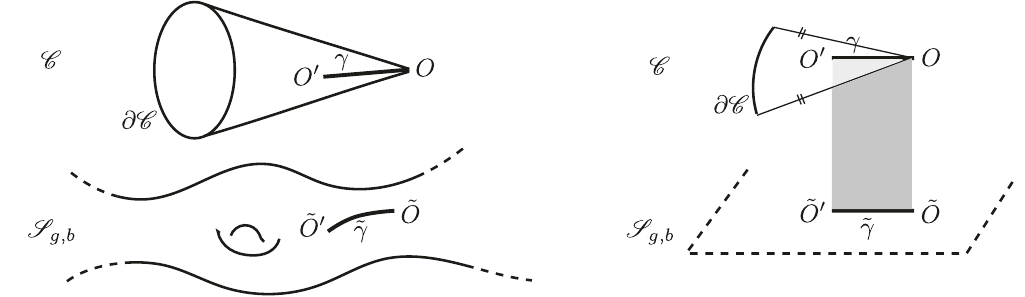
Figure 3 . Construction of surfaces with an arbitrary number of boundary components having k > 1 . By gluing together a cone C (that may also be a disk with no conical singularity at the origin) and an arbitrary surface S g,b along a short geodesic (thick lines OO 0 and ˜ O ˜ O 0 ), we get a new surface with one more k > 1 boundary and at least one conical singularity of angle strictly greater than 2 π . To facilitate the drawing, the points ˜ O and ˜ O 0 are chosen to be smooth. Left inset: surface sketch. Right inset: local two-sheeted representation; the two sheets are glued through the shaded